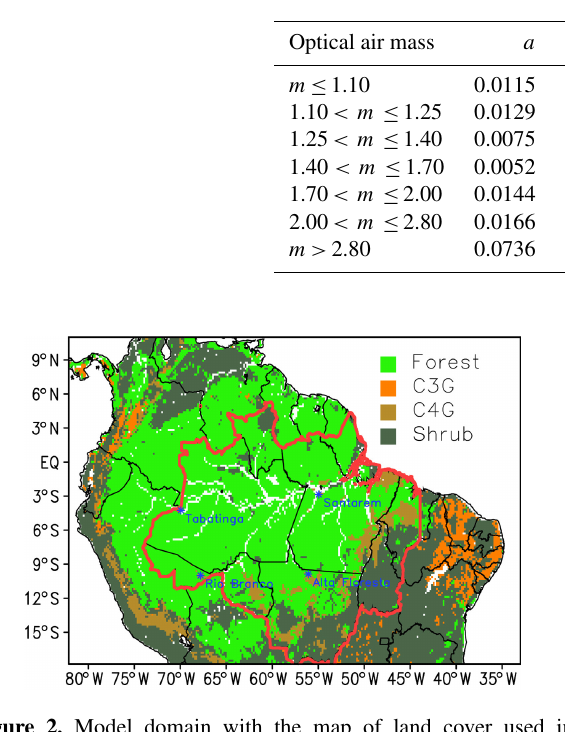
Figure 2. Model domain with the map of land cover used in BRAMS, with the color scale depicting the dominant biomes. The red contour line on the map delimits the LBAR and the locations of CO 2 and CO airborne measurements: Santarém, PA (2.85 ◦